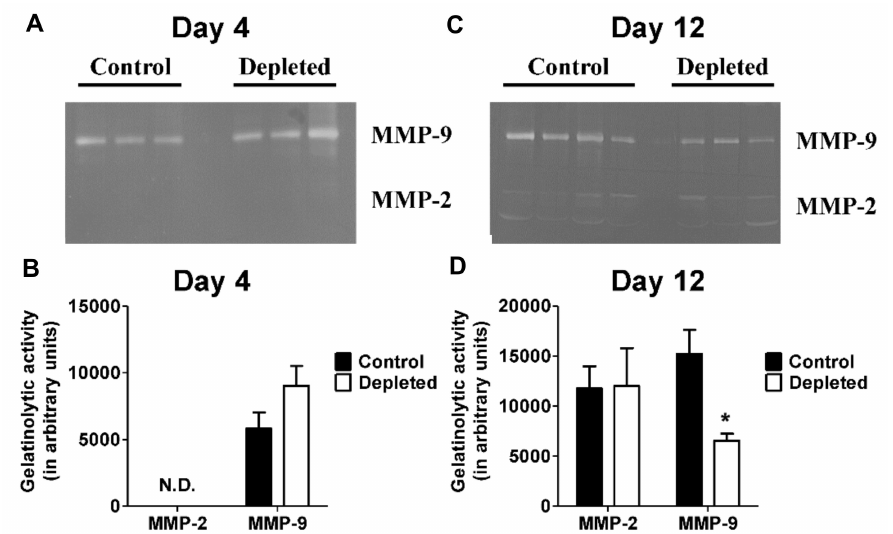
Figure 6. Depletion of T cells reduces intra-thrombotic gelatinolytic activity. ( A ) and ( C ) Gelatin zymogram gel images of intra-thrombotic MMP-2 and MMP-9 activities in venous thrombus samples from control and T cell depleted mice (Day 4 n = 3 control and 3 depleted, Day 12 n = 4 control and 3 depleted). ( B ) and ( D ) Quantitative analysis of gel images. N.D. = not detected. All values represent the mean ± SEM. * p < 0.05, control versus T cell